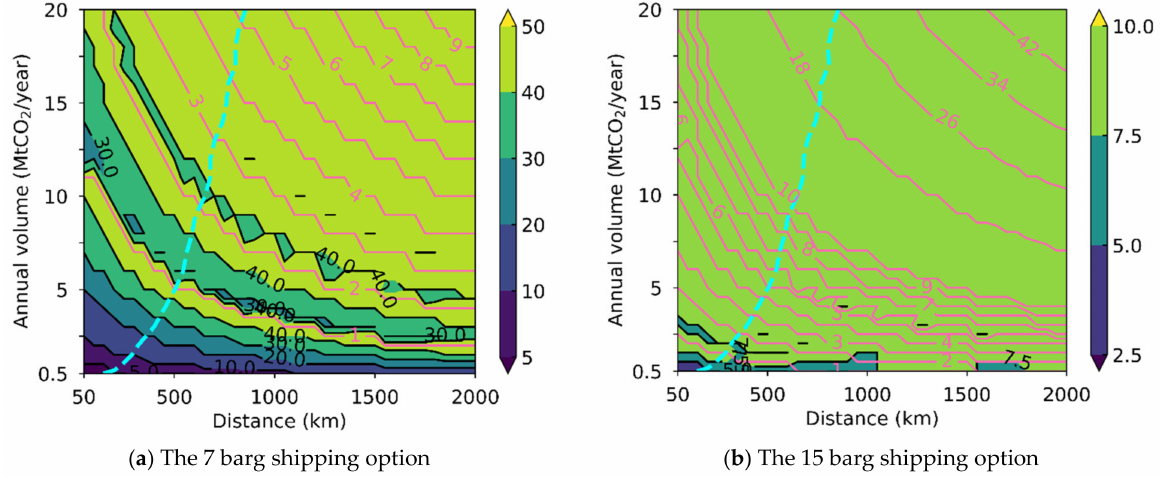
Figure 4. Cost comparison maps showing optimal ship size (ktCO 2 /ship) and fleet sizes in the case of shipping between two